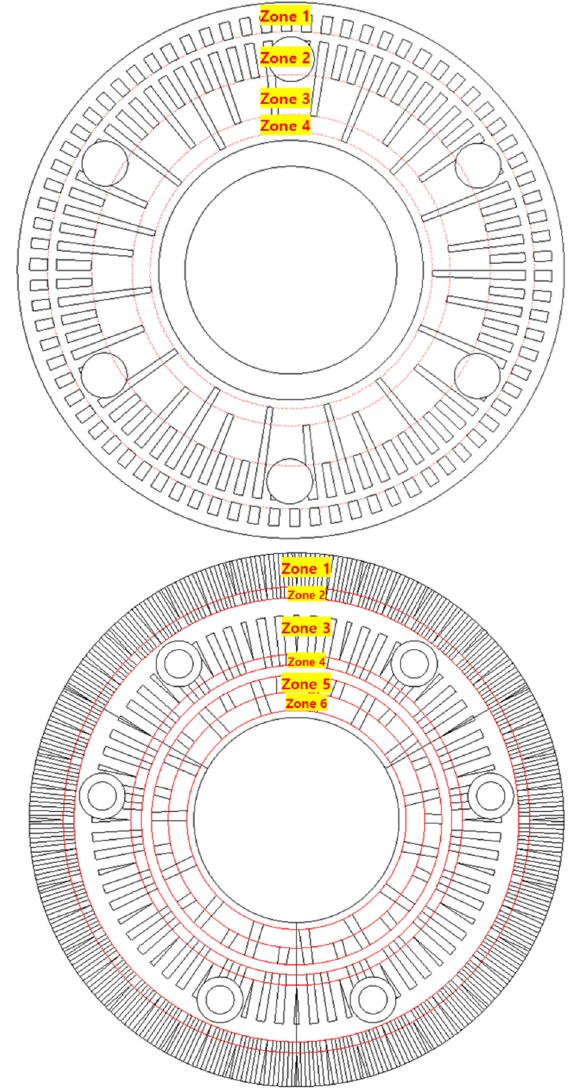
Figure 2. Zone classi fi cation of the plates based on bar lengths.